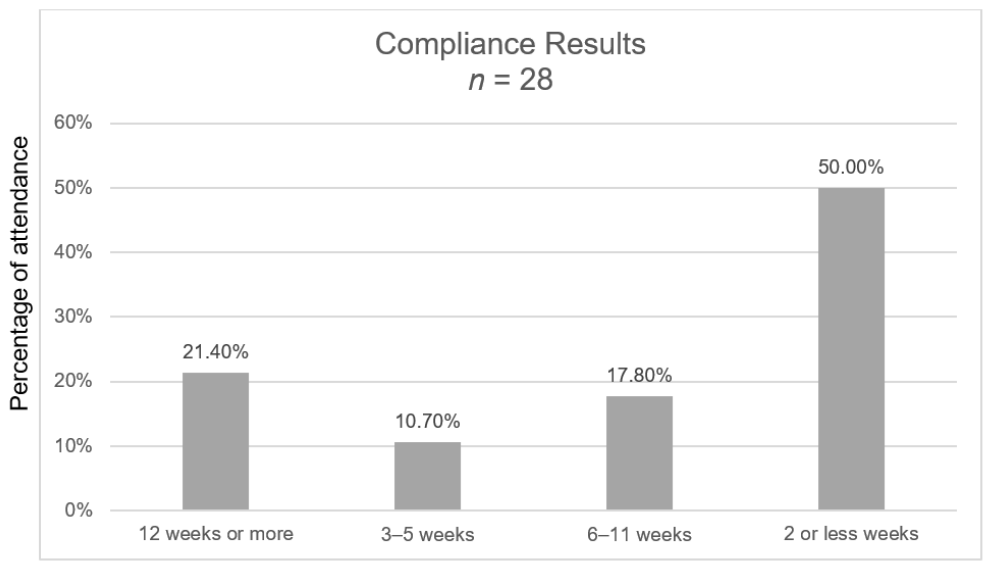
Figure 2. Compliance results. Table 1. OPALS feasibility questionnaire main results among participants completing six or more weeks of intervention.